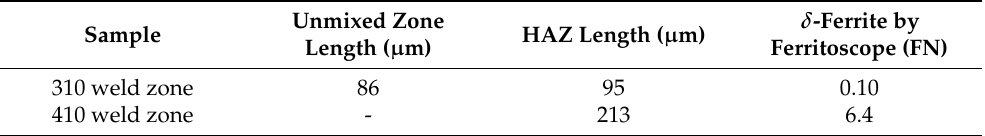
Table 4. Microstructural details of